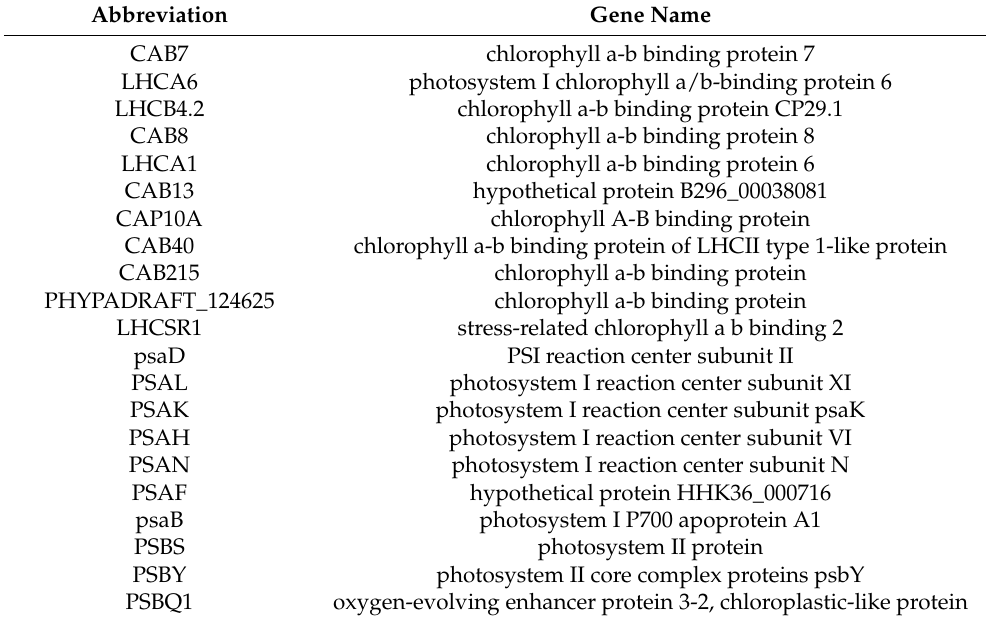
Table A3. Abbreviations used for DEGs involved in photosynthetic antenna proteins and